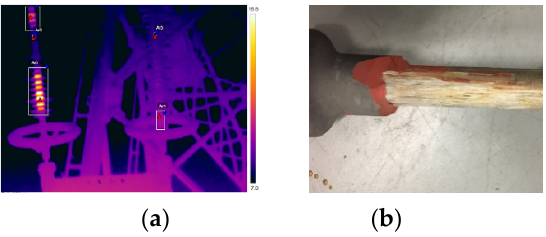
Figure 22. High temperature heating insulator: (a) Infrared image of the over-heated insulator; (b) Wood-like defect